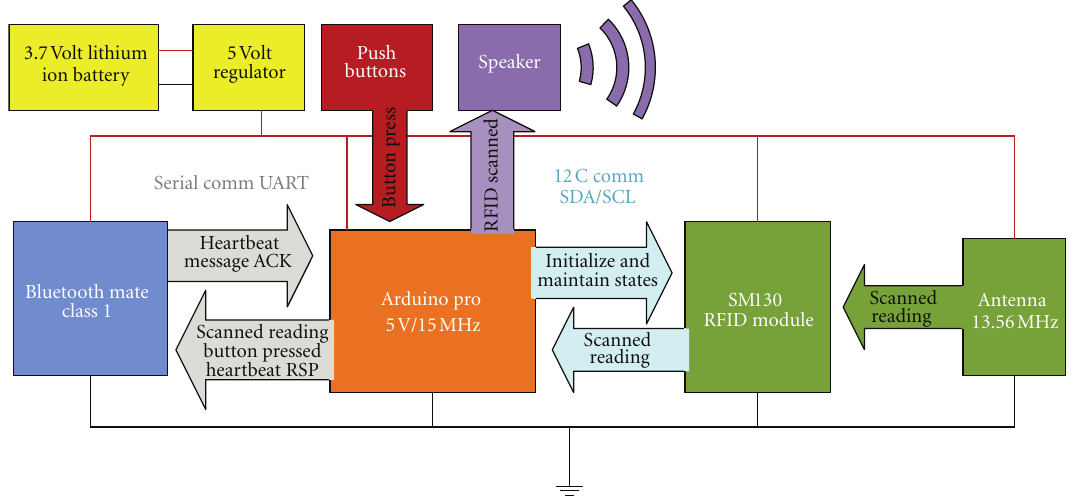
Figure 4: PERCEPT glove